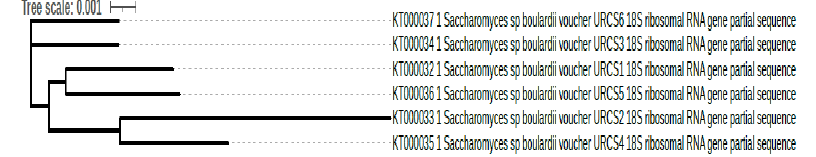
Figure 1. Phylogenetic tree based evolutionary relationships of the isolated probiotic yeasts from frozen idli batter.